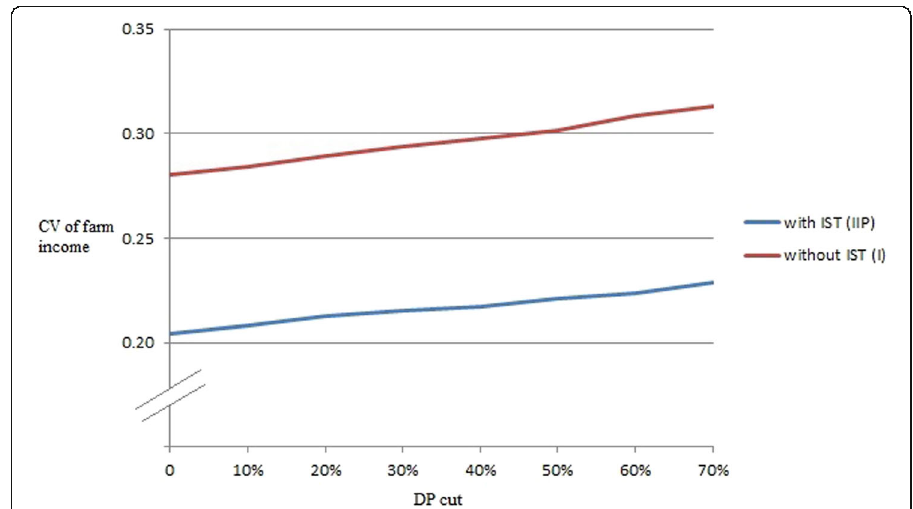
Fig. 1 Variability of farm income (CV) with IST (IIP) and without the IST (I) for different reductions of direct payment level for all farm samples. Median of the CV of farm income calculated on each individual farm over the period 2012 – 2015. Source: Own elaborations on Italian FADN